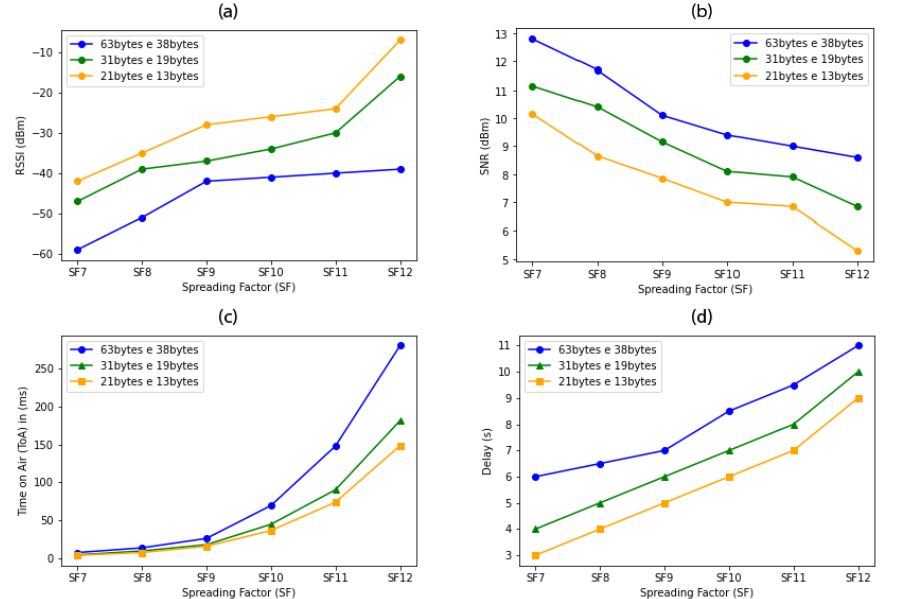
Figure 19. LoRaWAN behavior ( a ) RSSI, ( b ) SNR, ( c ) ToA and ( d ) Delay of packets sent by